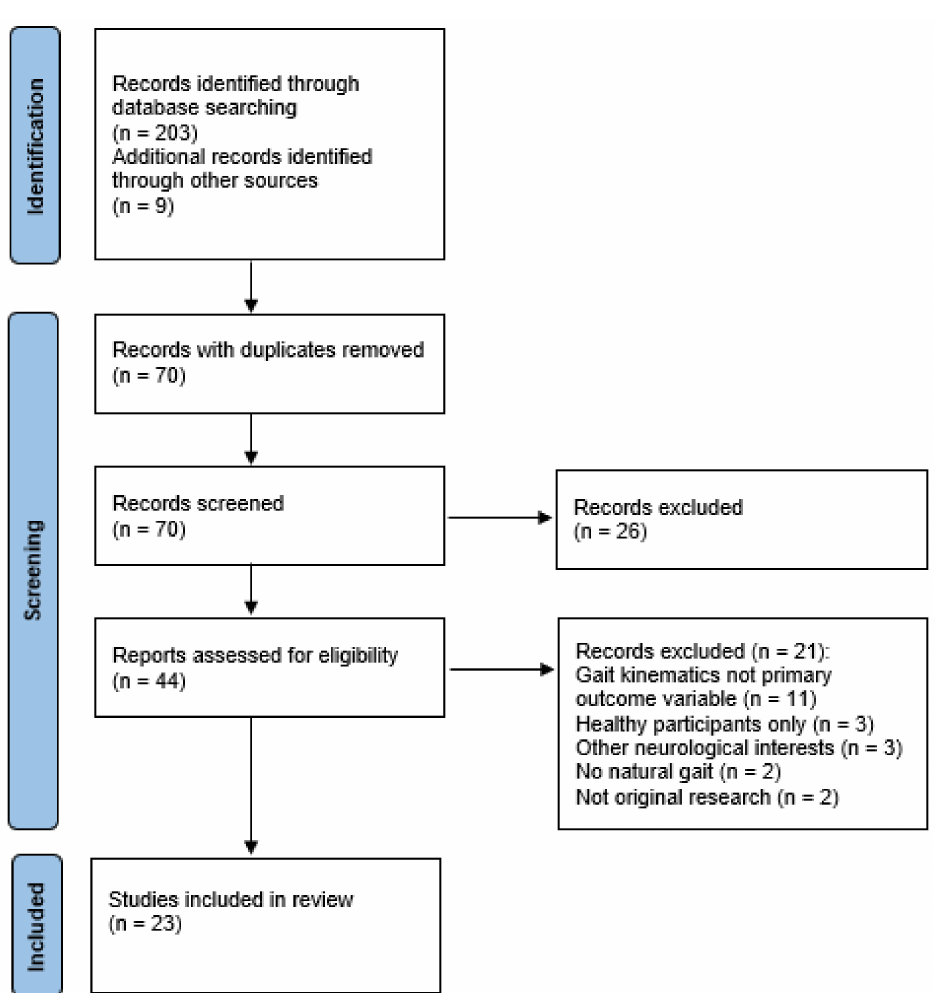
Figure 1. PRISMA-ScR flow diagram of the study selection process. The flow of information through the review phases is depicted, detailing the number of articles that were included and excluded in the review, with reasons for